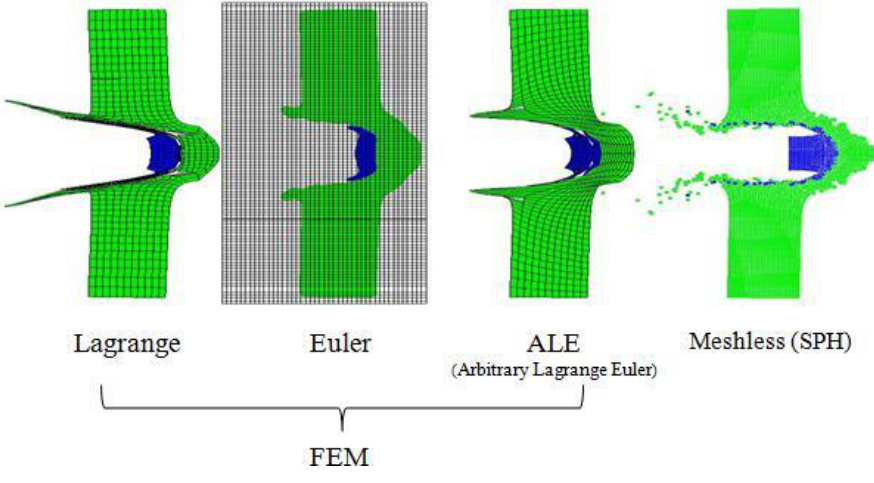
Figure 1. A material impact simulation by using FEM accounting for different re-meshing skills, Lagrange, Euler and Arbitrary Lagrange Euler (ALE), and smoothed particle hydrodynamics (SPH)